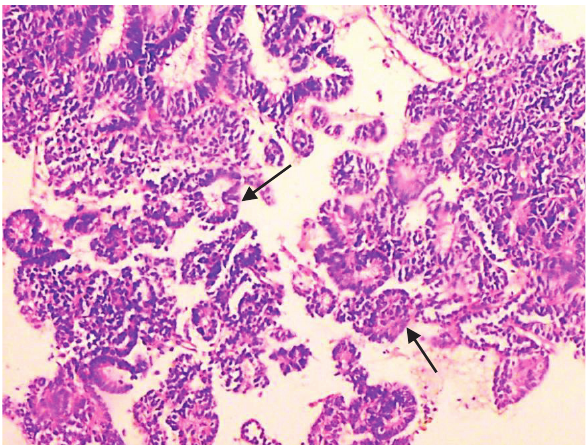
Fig-2: Photomicrograph of H&E staining showing neoplastic tubules (arrows) in residual Wilms Tumor X 20